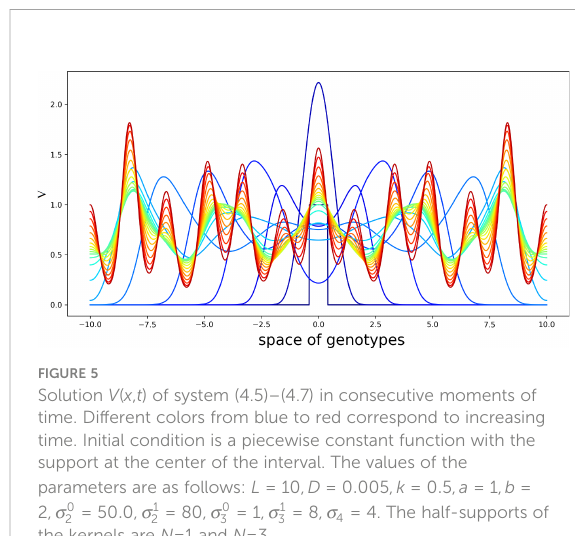
FIGURE 4 Level lines of the function V ( x , t ) in Figure 3 on the ( x , t )-plane. The support of the initial condition is located at the center of the interval. After some time, new peaks of the virus density distribution emerge from both sides of it. The same values of parameters as in Figure 3.